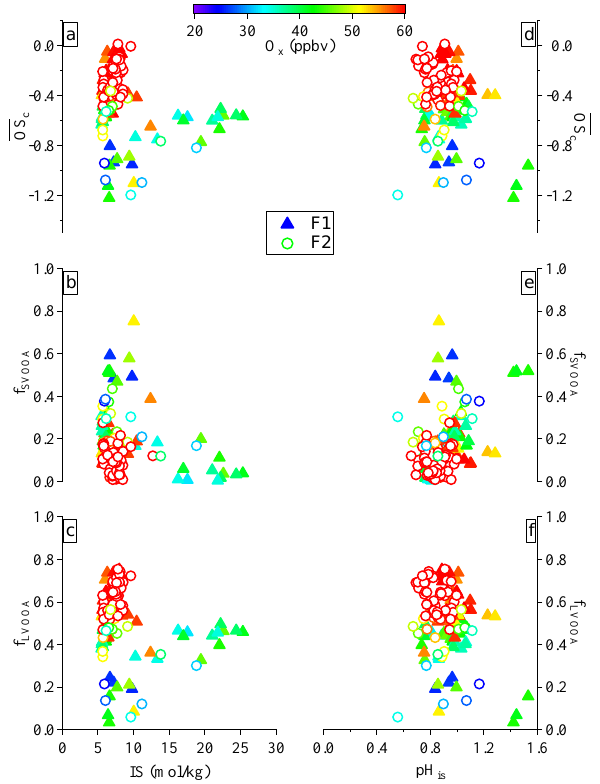
Fig. 7. Hourly averaged carbon oxidation state (OS c ) (a) , SVOOA fraction ( f SVOOA ) (b) , and LVOOA fraction ( f LVOOA ) (c) for F1 (blue solid triangles) and F2 (green open circles) plotted against estimated ionic strength (IS). Carbon oxidation state (OS c ) (d) , SVOOA fraction ( f SVOOA ) (e) , and LVOOA fraction ( f LVOOA ) (f) for F1 (blue solid triangles) and F2 (green open circles) plot- ted against estimated fine-particle in situ pH (pH is ) . Data points are color-coded according to O x